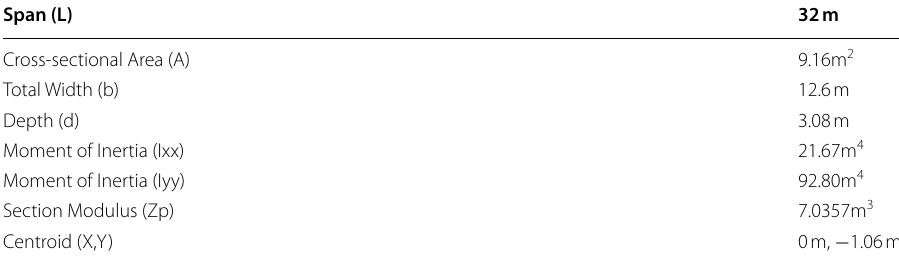
Table 1 Sectional Properties of Bridge Deck